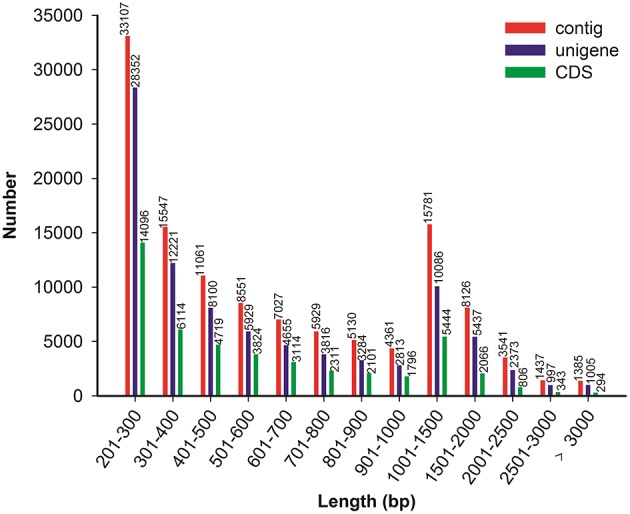
Overview of the P. ternata transcripts assembly and the length distribution of the CDS.